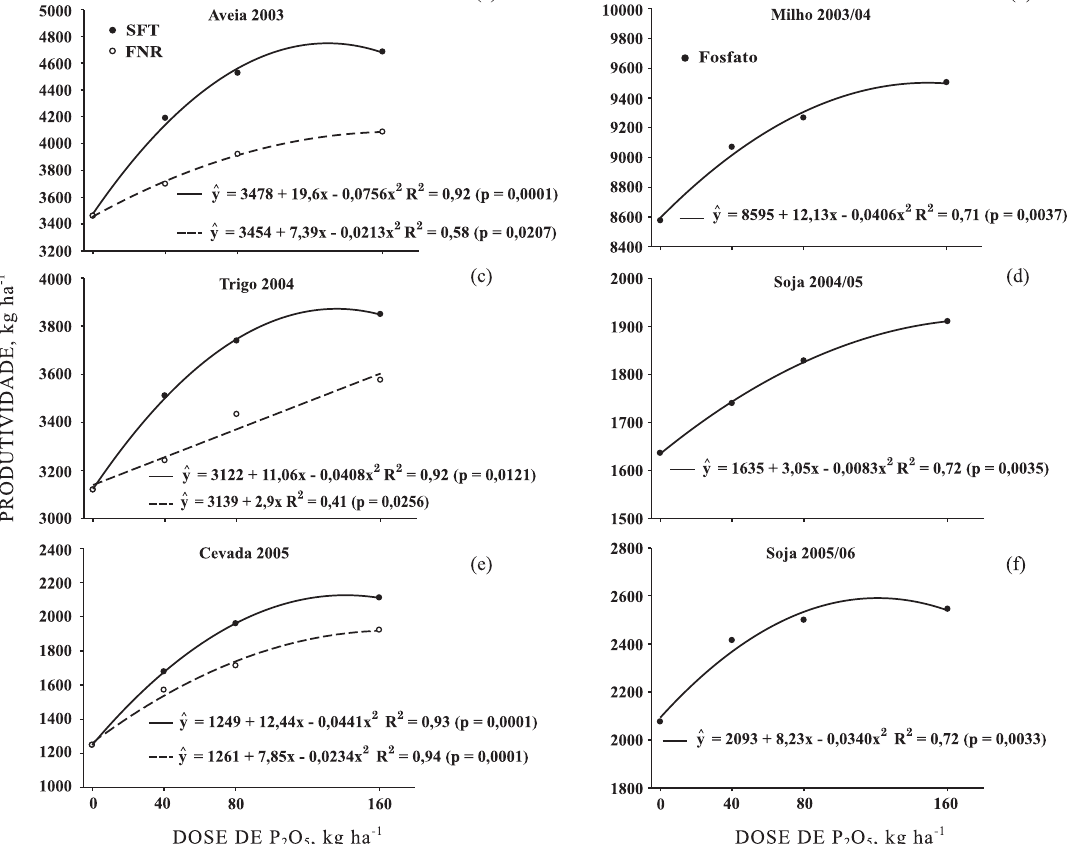
Figura 2. Produtividade de grãos das culturas no segundo ciclo de rotação (2003 – 2006), com a aplicação de doses de fósforo na forma de superfosfato triplo (SFT) e fosfatos naturais reativos (FNR) Gafsa e Arad, sendo considerada a média das fontes nas culturas que não diferiram estatisticamente (p < 0,05). O uso dos termos “fosfatos” e “FNR” indica que os valores correspondem, respectivamente, à média de todos os fosfatos e à média dos fosfatos